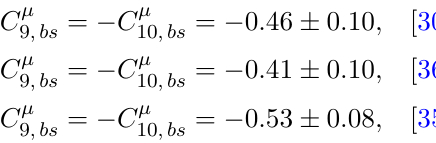
and C NP from the (cid:12)t using one bin (left plot) and three 9 10 = (cid:0) C NP 9 10